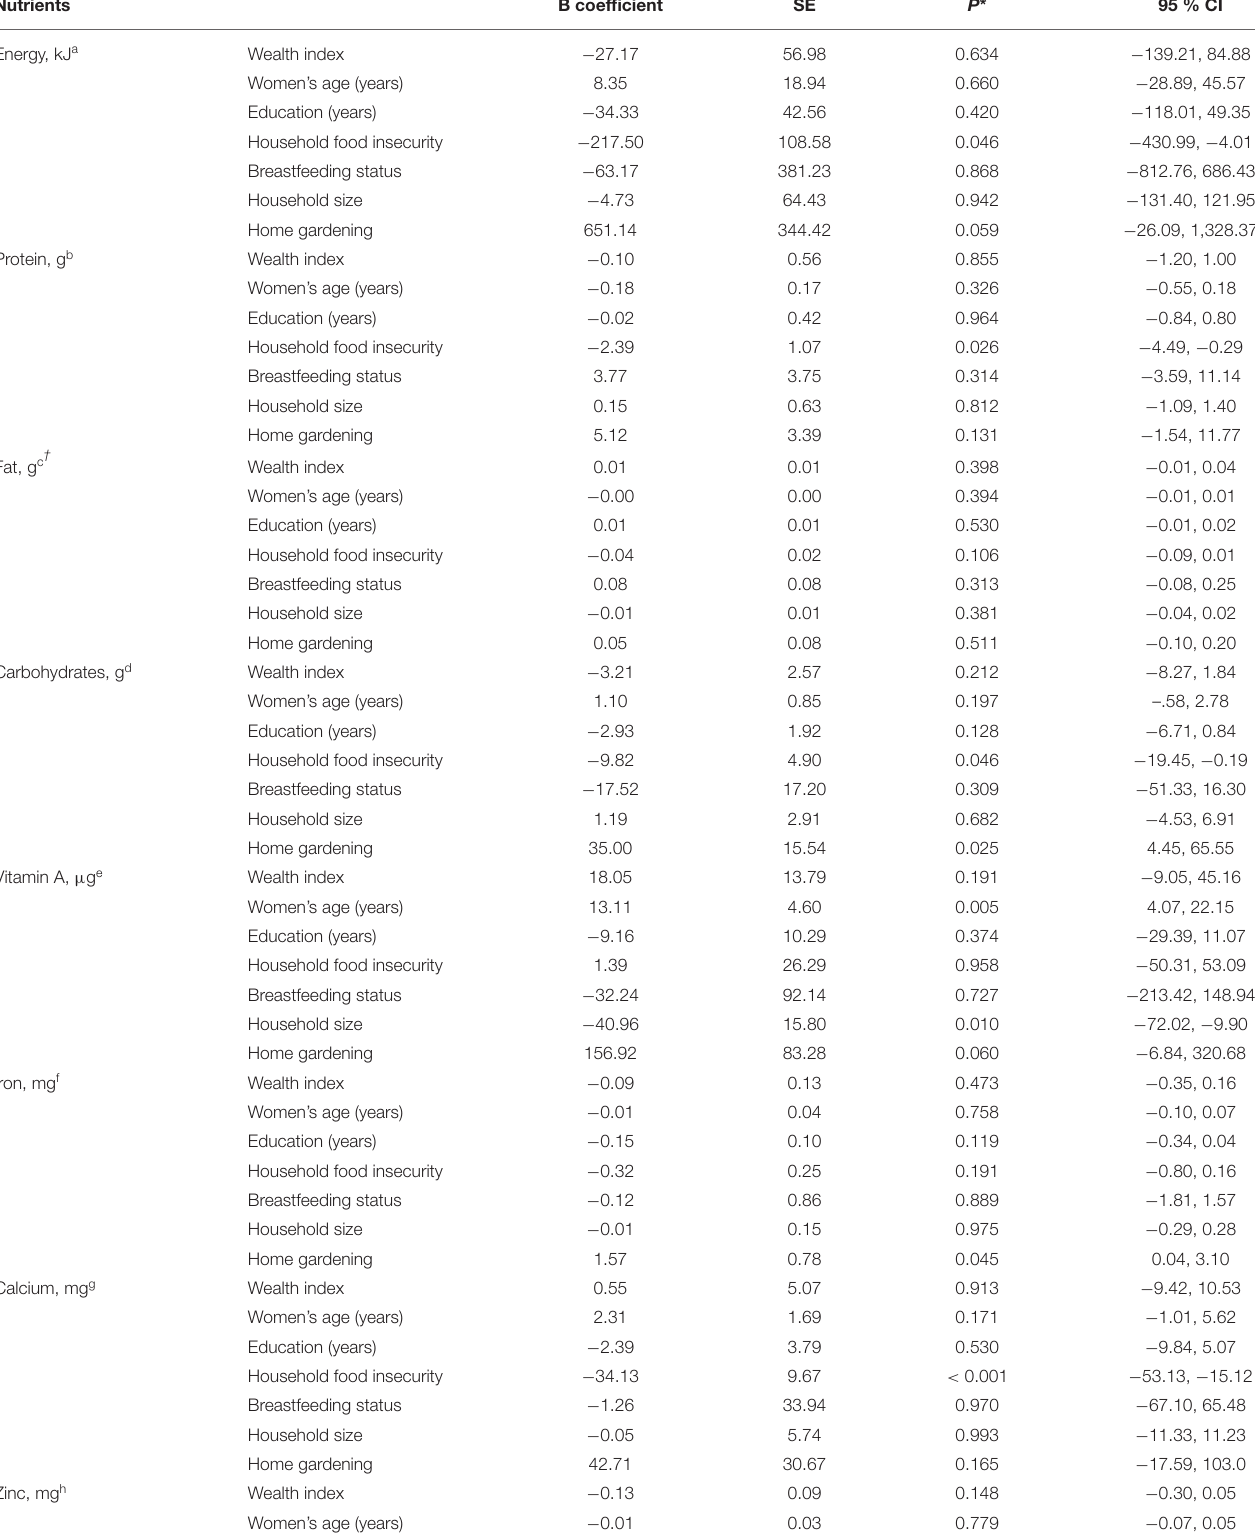
TABLE 8 | Factors influencing nutrient intakes among women in Western Kenya ( n = 404).